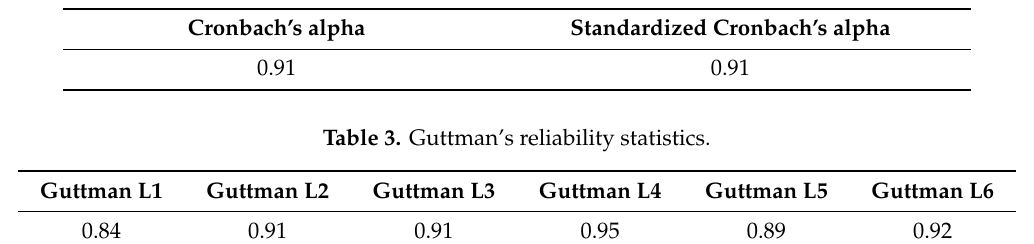
Table 2. Cronbach’s alpha reliability statistics.